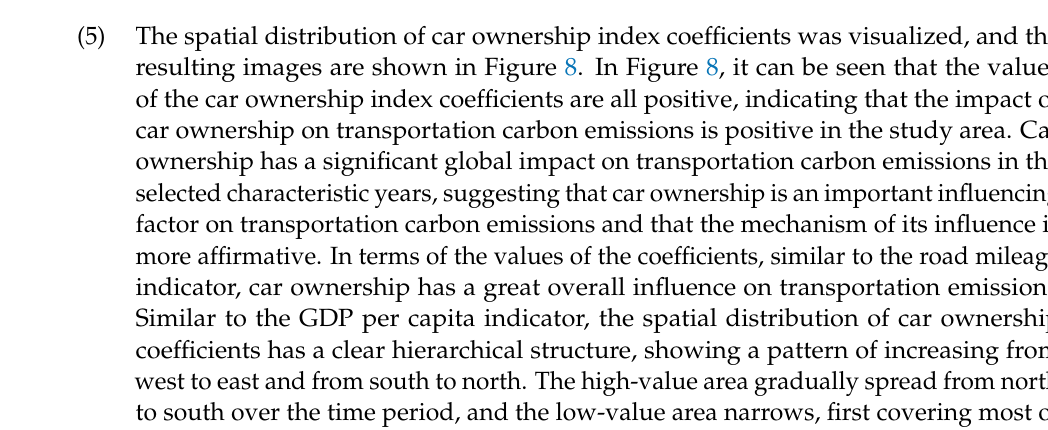
Figure 7. Spatial distribution of road mileage indicator